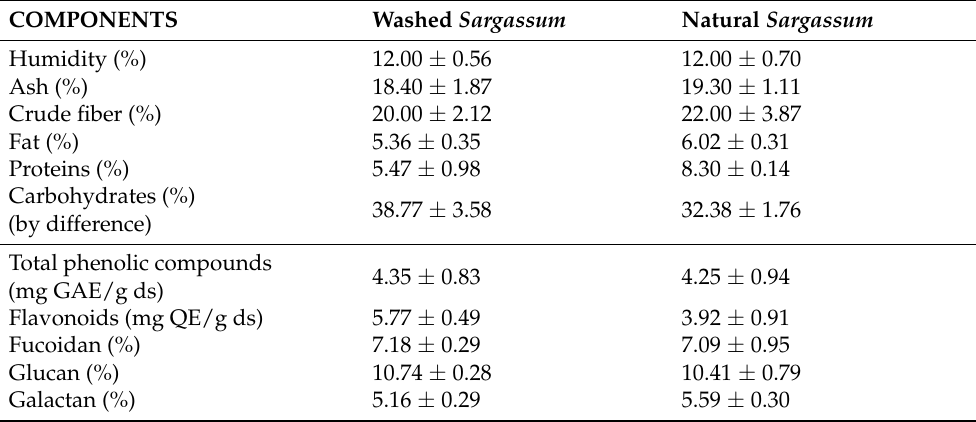
Table 1. Wet-based characterization of samples of washed Sargassum and natural Sargassum used as raw material for